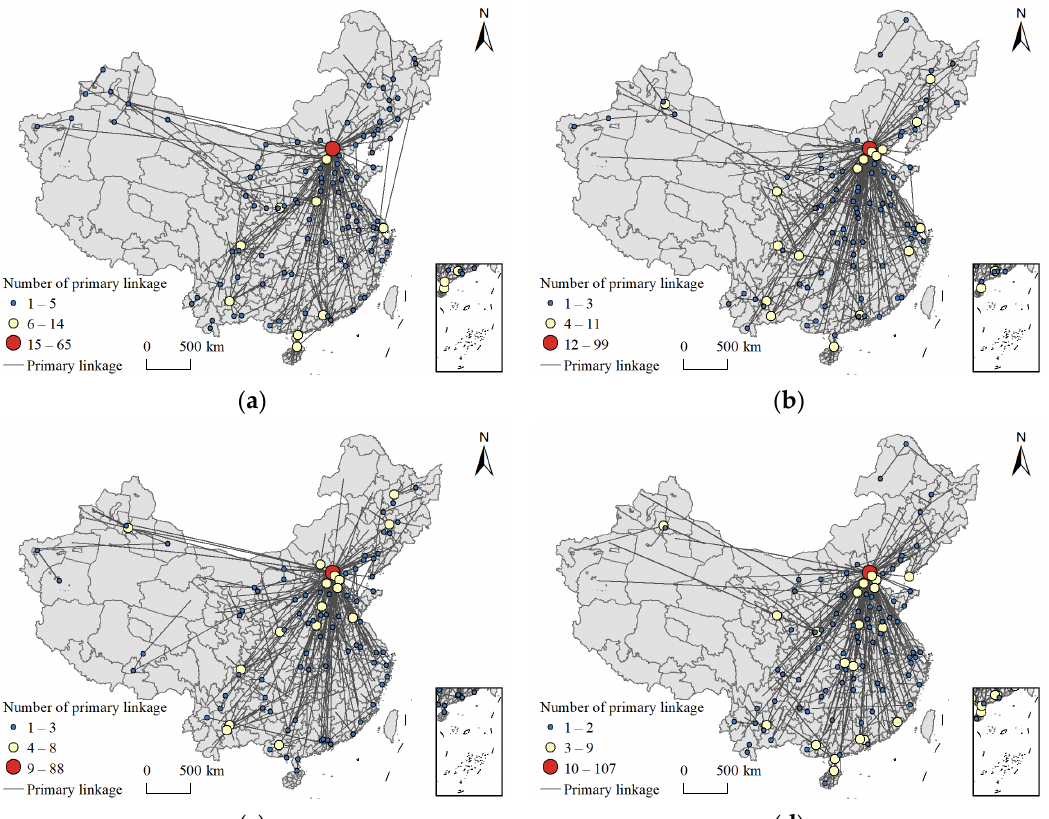
Figure 4. Comparison of the accumulation probability of the linkage strength between city ‐ pairs.